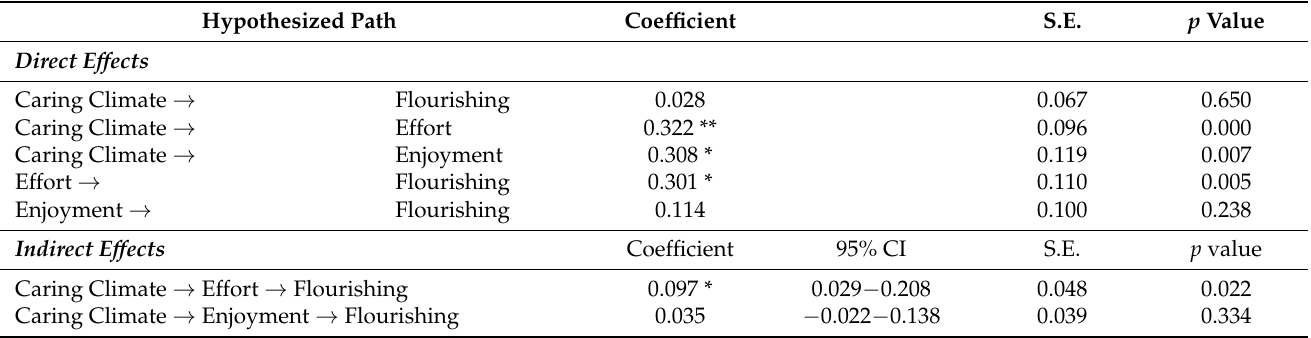
Figure 3. Mediation Analyses: Model 2. Note: Model fit (CFI = 0.93, TLI = 0.92, RMSEA = 0.06, and SRMR = 0.06). Significant theory-driven regression paths (* p ≤ 0.05; ** p ≤ 0.001) are presented in the model. The standardized regression coefficients are presented for each significant path. Significant indirect effect was: Caring Climate → Effort → Flourish (0.10). Table 4. Model 2 parameter estimates, standard error, and p values.